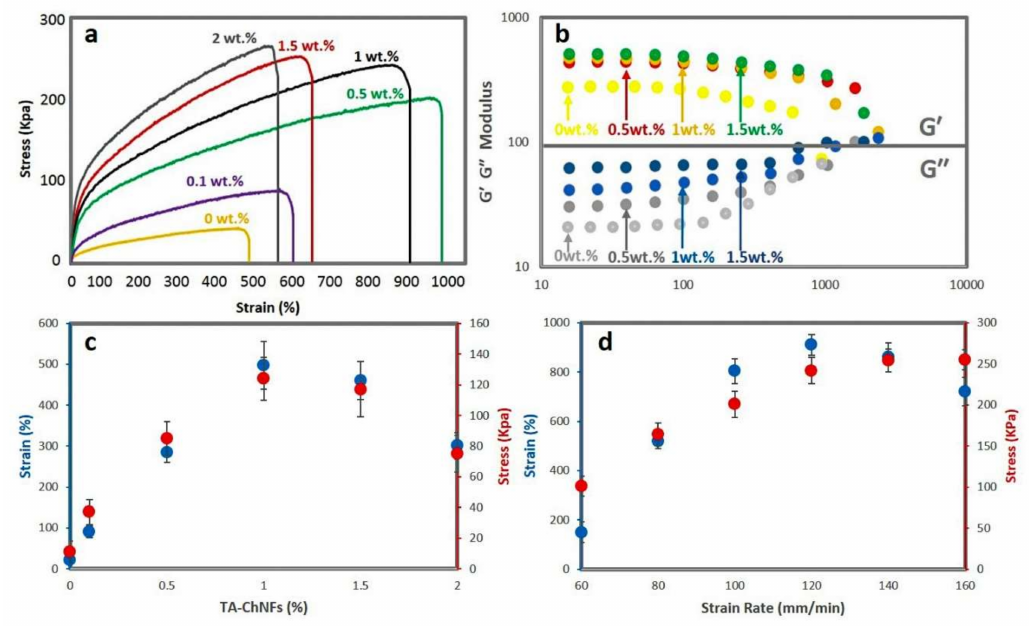
Figure 2. ( a ) Tensile stress–strain curves of PAA / St hydrogels at di ff erent TA-ChNFs concentrations; ( b ) Storage modulus and loss modulus of the hydrogel at di ff erent TA-ChNFs percentages; ( c ) tensile properties for notched hydrogels at di ff erent TA-ChNFs concentrations; ( d ) tensile properties of the hydrogel reinforced by 1 wt.% TA-ChNFs at di ff erent strain